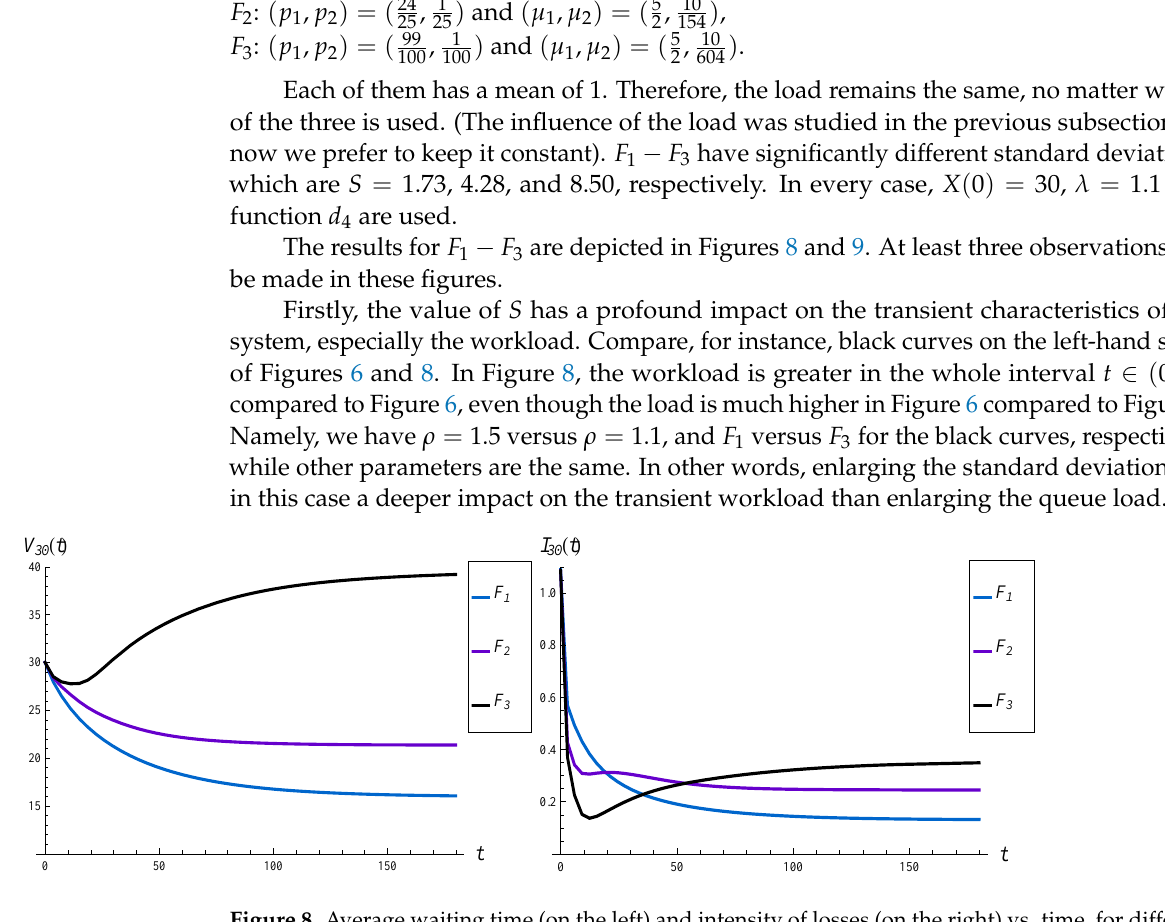
Figure 8. Average waiting time (on the left) and intensity of losses (on the right) vs. time, for different distributions of the service time.